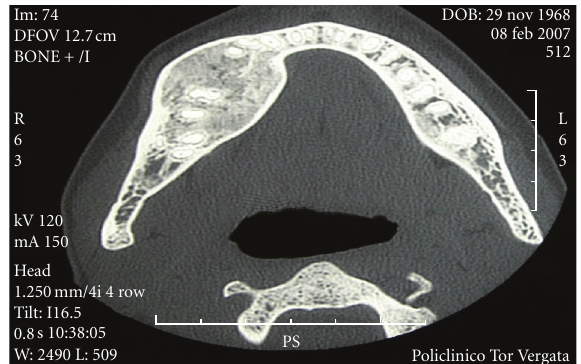
Figure 3: (February 08, 2007) TC deltascan reveals a thickening of alveolar bone of the right mandibular arch with a deformity of profile without a gap of cortical and reveals the regular morphology along the mandibular canal, without sure images referable to infiltration on